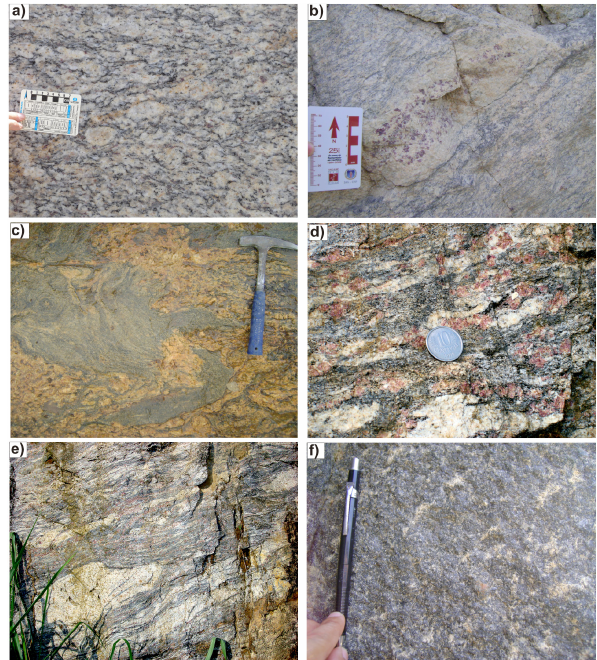
Figure 3. Pictures of outcrops representative of the studied rocks: (a) an example of diatexite with well-marked magmatic foliation characterized by the preferred alignment of biotite and feldspar; (b) diatexite with leucosome rich in garnet and feldspar; (c) diatex- ite displaying a scholle feature. (d) and (e) : migmatitic kinzigites displaying stromatic leucosomes embedded between gneissic folia- tions; (f) a migmatitic granulite with small pockets of